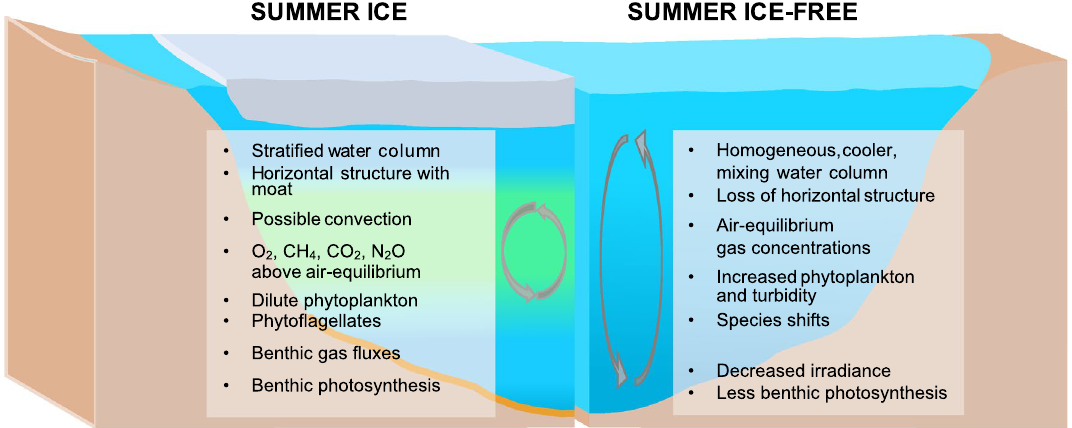
Figure 7. Summary of limnological observations in Ward Hunt Lake. Conditions under the mid-summer ice of Ward Hunt Lake and potential changes associated with loss of that ice in the